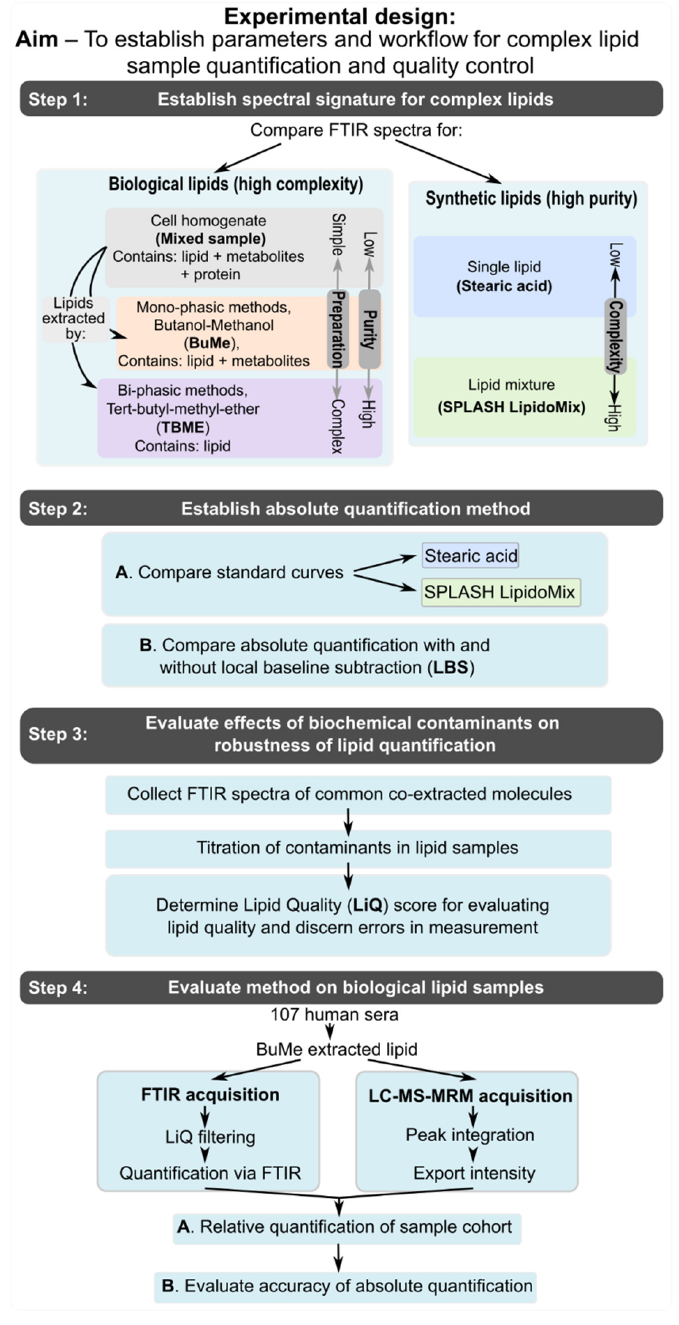
Figure 1. Experimental design evaluating FTIR spectroscopy parameters for complex lipid mixture quantification and quality control.